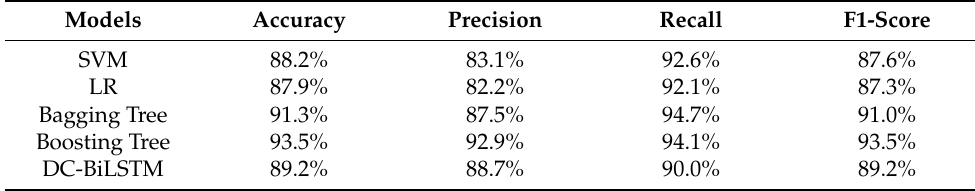
Table 6. Comparative analysis of the performance of multiple classifiers in distinguishing between benign and malignant tissue. The performance metrics are for the external test dataset.